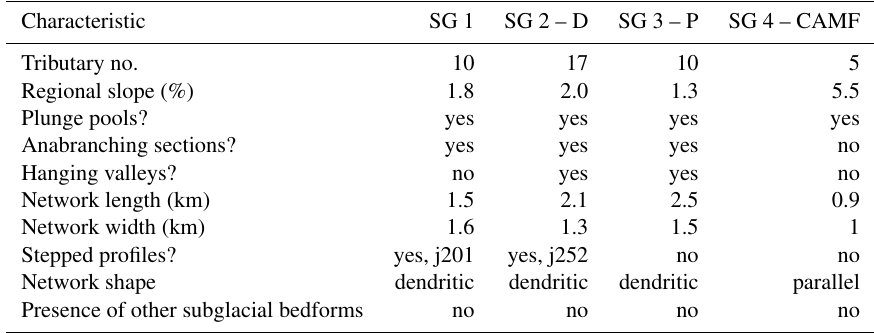
Table 3. Summary of morphological characteristics. Characteristic